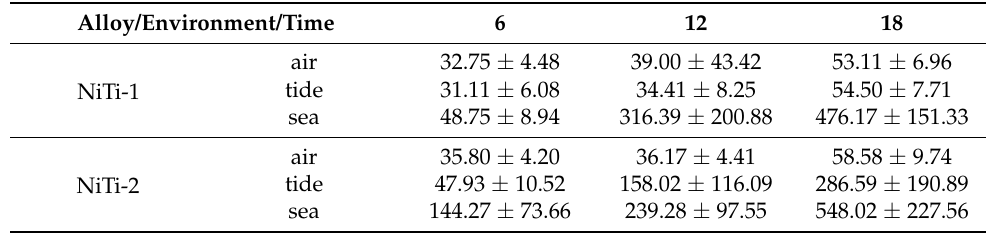
Table 5. Mean values and Standard Deviations ( µ ± σ ) of measured corrosion wear on the NiTi-1 and NiTi-2 alloys exposed to the influence of air, tide and sea, measured after 6, 12 and 18